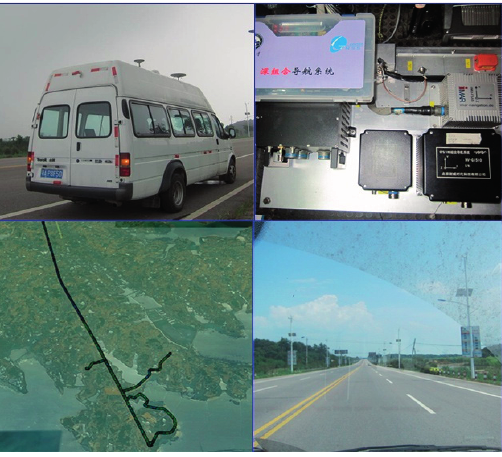
Figure 17. Setup of vehicle